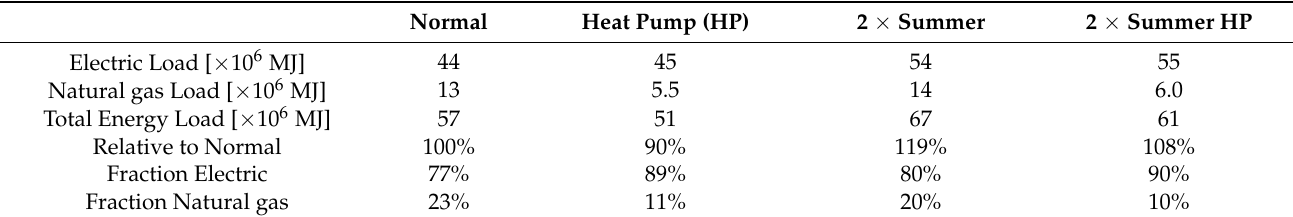
Table A2. Summary of NWC annual energy loads. The 2 × Summer profile increases total energy load by 19% over Normal. Implementing Heat Pump (HP) technology increases both the electric load and fraction of electric, but reduces natural gas load by more than half, such that the total energy load is reduced by 10% for both Normal and 2 × Summer profiles.